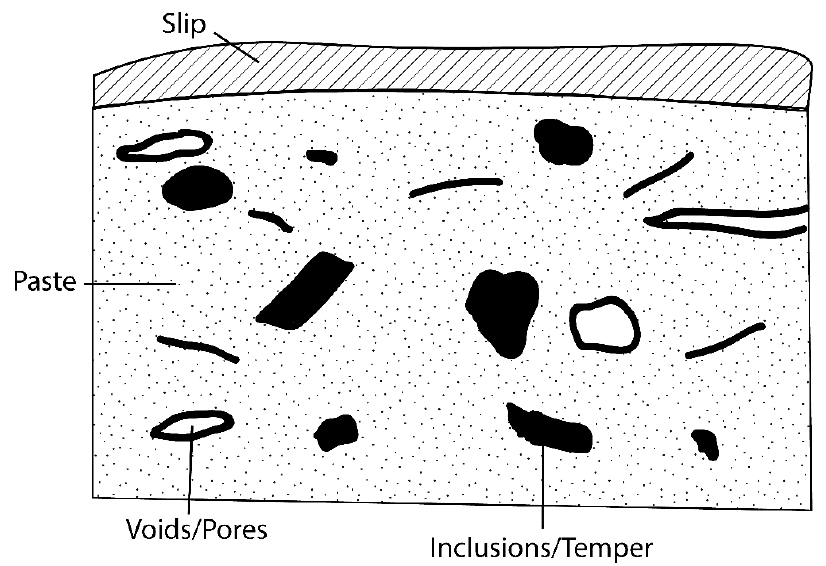
Figure 1. Diagram of a typical cross section of a ceramic object, including a slip, the paste, voids and inclusions. After [45] (p. 122, Figure 2).